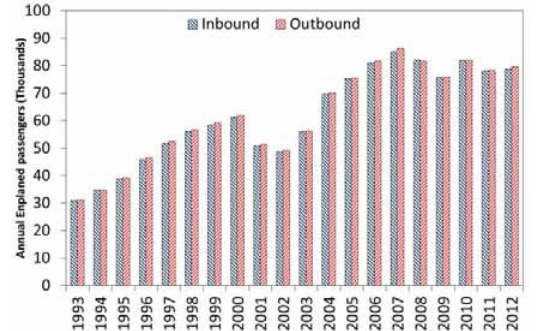
Fig. 3. Annual growth in Mildura Airport RPT inbound and outbound passenger traffic: 1993–2012 (Bureau of Infrastructure, Transport and Regional Economics 2014)